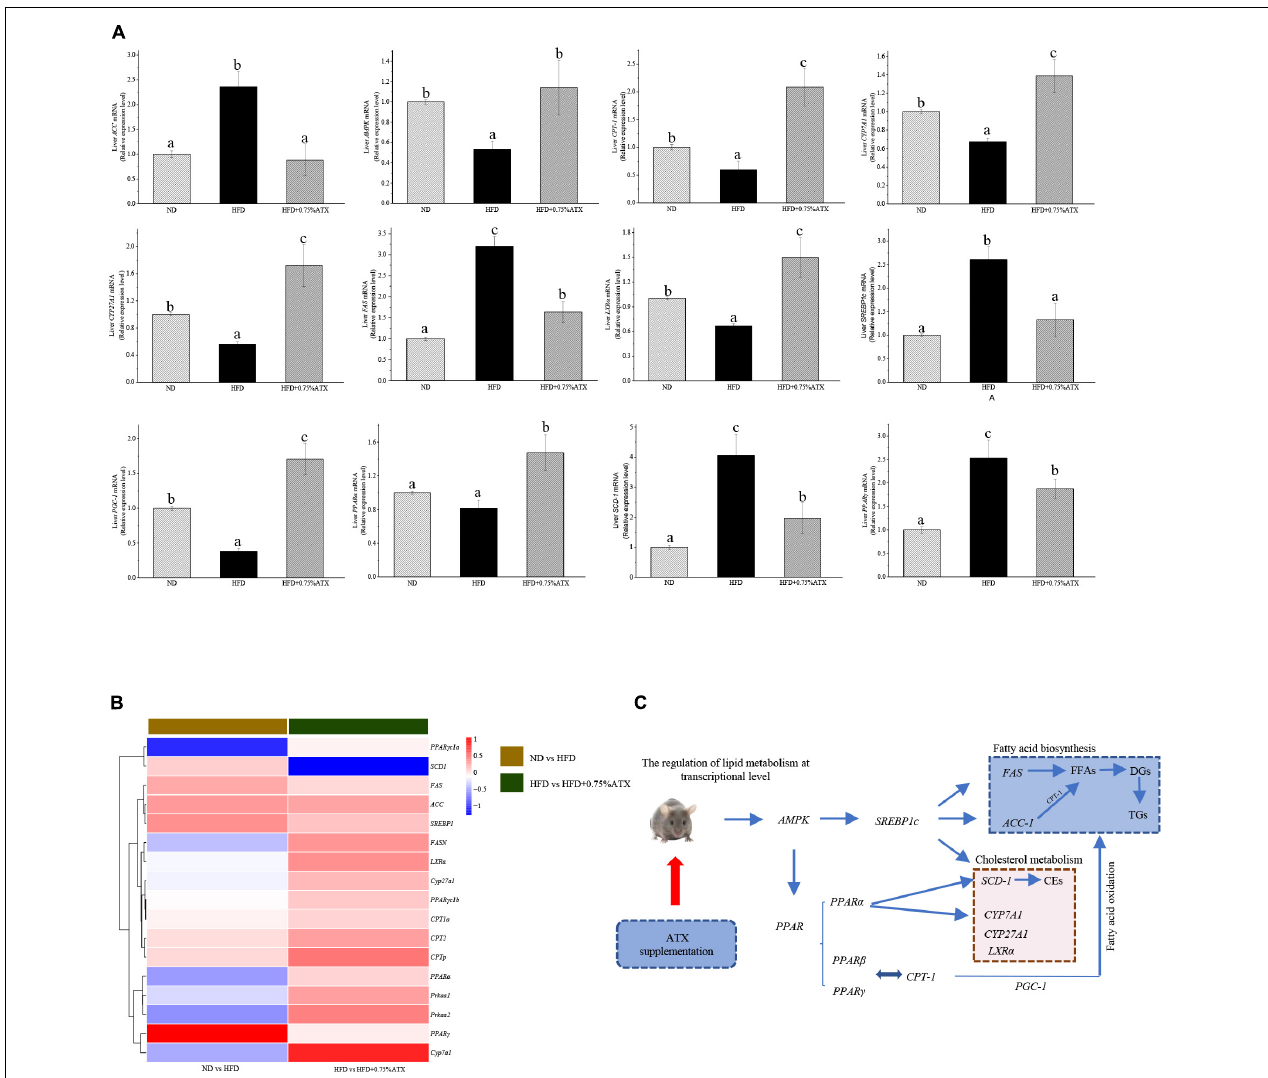
FIGURE 4 | Astaxanthin significantly improved relative gene expression. (A) Gene expression levels in AMPK/SREBP1c pathway. (B) The heatmap of differential genes expression at the transcriptional level. (C) Regulatory effects of ATX supplementation on fatty acid and cholesterol metabolism in mice induced by HFD. Data are shown as mean ± SD of triplicate. The different letters (a–c) indicate significant differences ( P < 0.05) according to Duncan’s multiple range test in